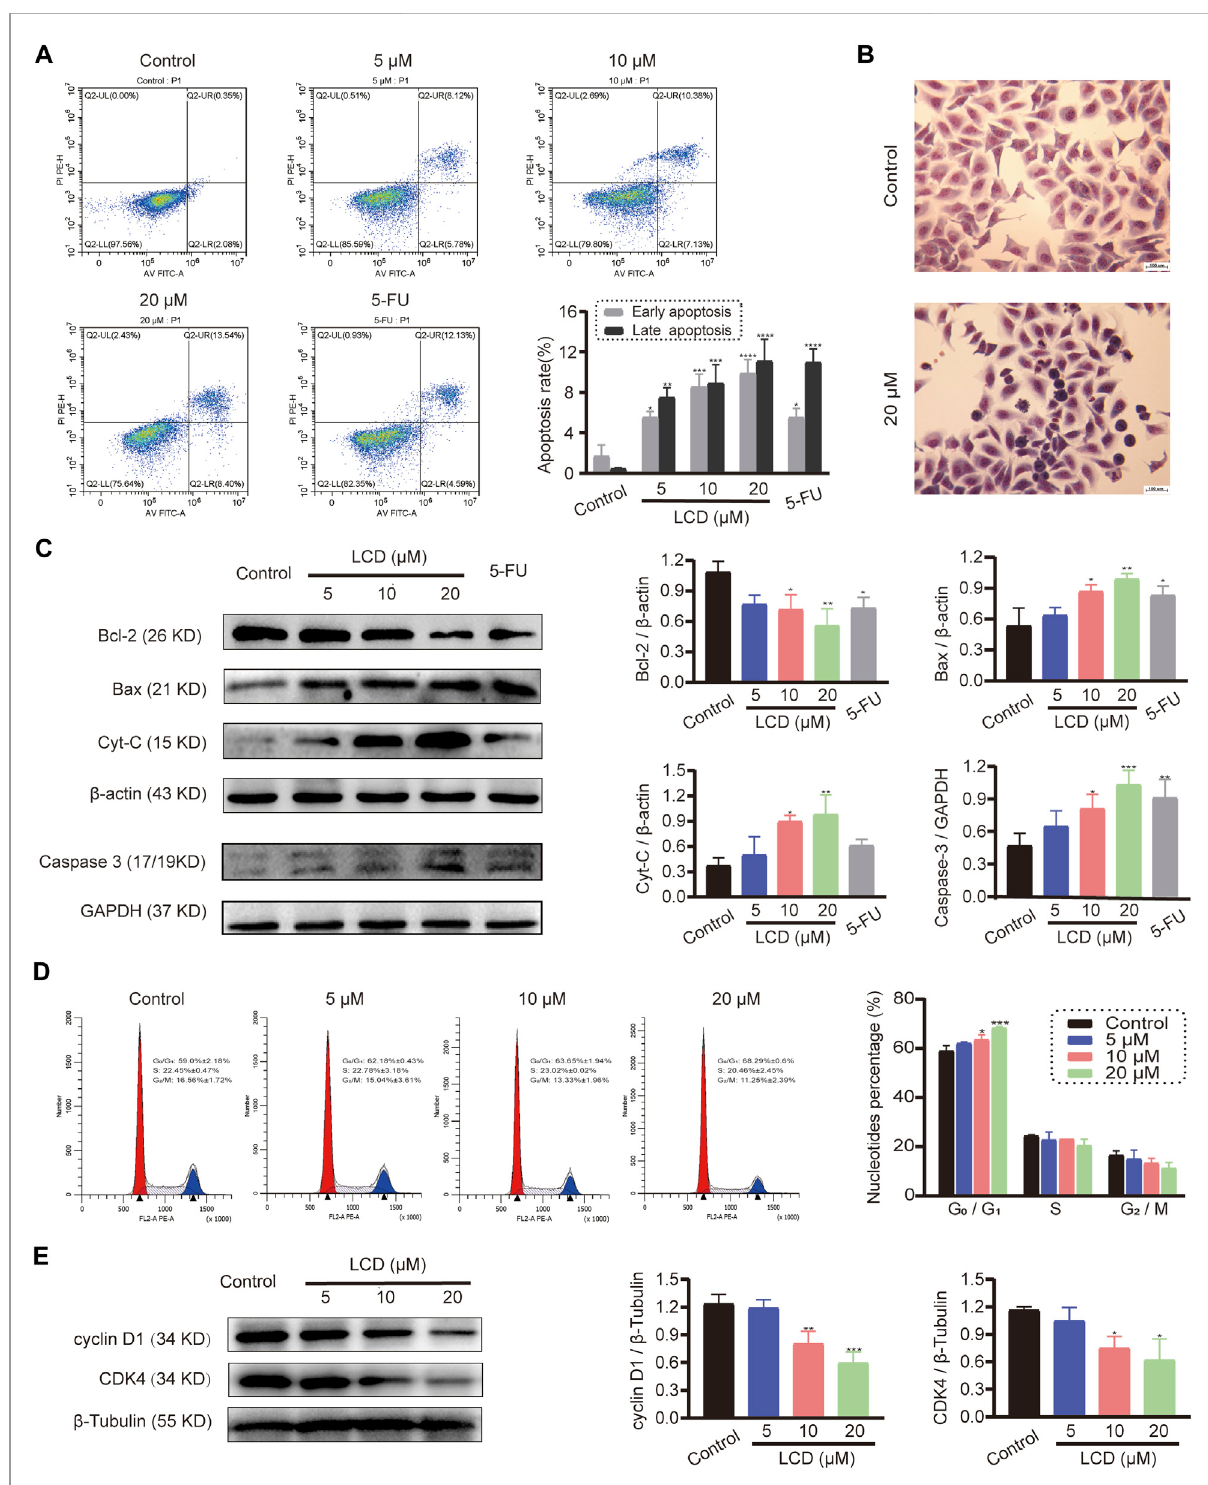
FIGURE 2 Licoricidin promoted MGC-803 cell apoptosis and arrested mitosis in the G 0 /G 1 phase. MGC-803 cells were treated with licoricidin (5, 10, and 20 μ M) or 5- fl uorouracil 20 μ Mfor 24 h. (A) Apoptosis of MGC-803 cells was detected by fl ow cytometry after Annexin Ⅴ -FITC/PI dual staining, and the percentage rate of apoptotic cells was displayed in the histogram. (B) Morphological changes of MGC-803 cells were observed by Giemsa dye liquor (×200). Compared with the untreated group, cells treated with 20 μ M of licoricidin presented a different morphology, and particularly, typical manifestations of apoptotic cells, such as nuclear pyknosis, hyperchromasia, and apoptotic bodies, can be seen. (C) Expression levels of